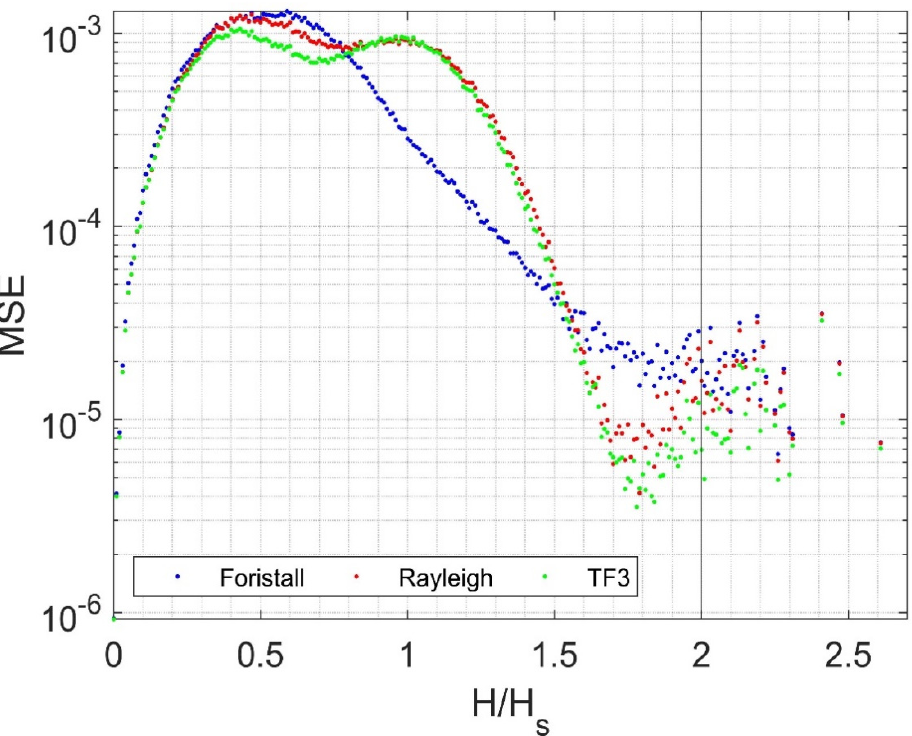
Figure 8. Quantitative comparison of all data MSE from January 2017 until May 2018. MSE averaged across all data sets of all events.